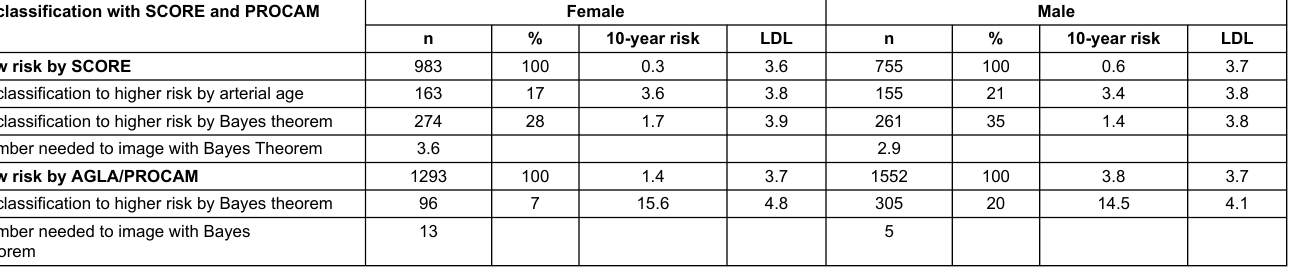
Table 5: Reclassification based on carotid atherosclerosis in low risk subjects calculated for sex and risk assessment tool (SCORE/PROCAM) using either vascular age (SCORE only) or Bayes theorem (SCORE and PROCAM). Reclassification with SCORE and PROCAM